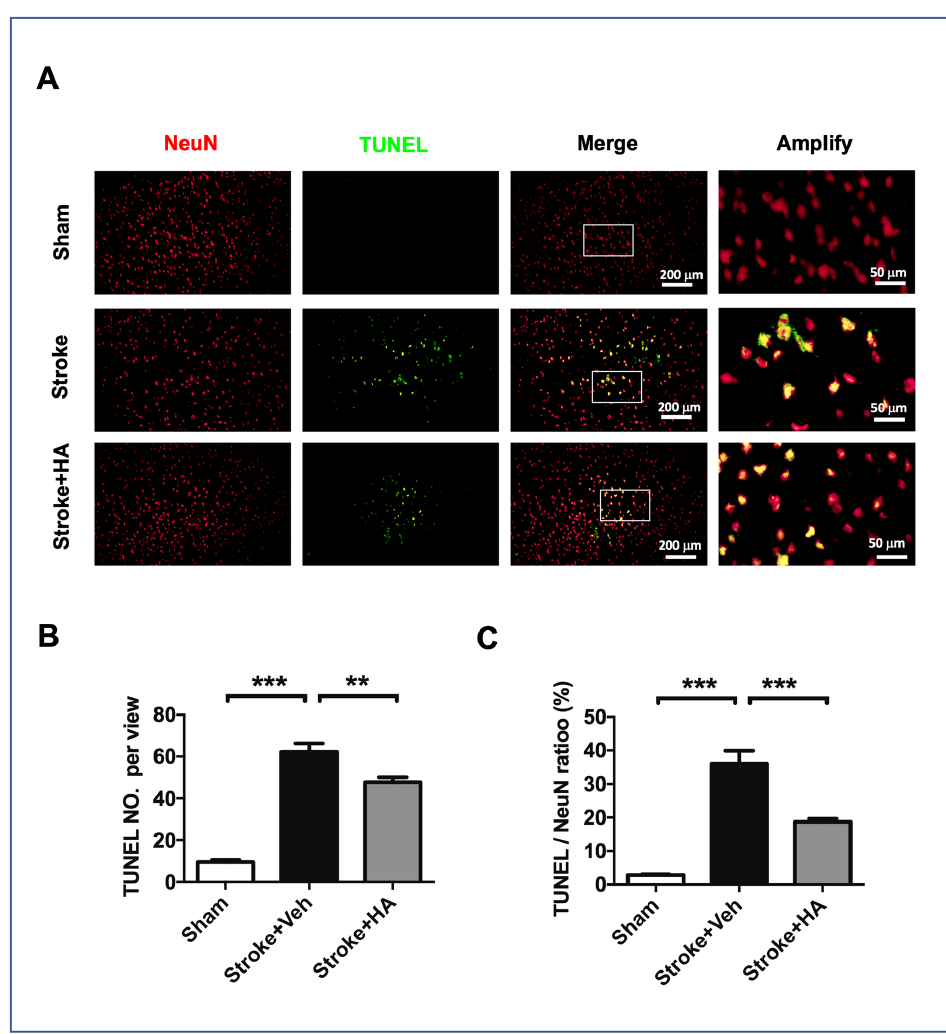
Figure 6 Figure 6. HA treatment ameliorated DNA breaks in the brain of rats after ischemic stroke. ( A ) Representative figures of TUNEL staining were conducted in rats with brain ischemia 3 days after stroke; immunofluorescent co-staining for NeuN was conducted to label neurons. ( B ) Quantified data of mean cell number with TUNEL signal in each view. ( C ) Quantified data of mean cell number with TUNEL signal and NeuN immunoreactivity in each view. Data quantification accumulated twenty image views across six brain sections per brain from cortex penumbra. n = 8. ** Denotes p < 0.01, *** denotes p <